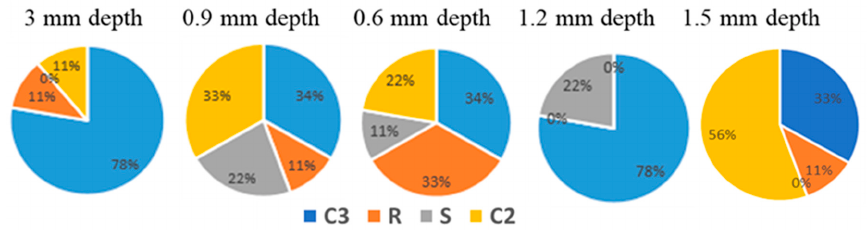
Figure 8. SNR distribution for each experiment with its corresponding defect depth.